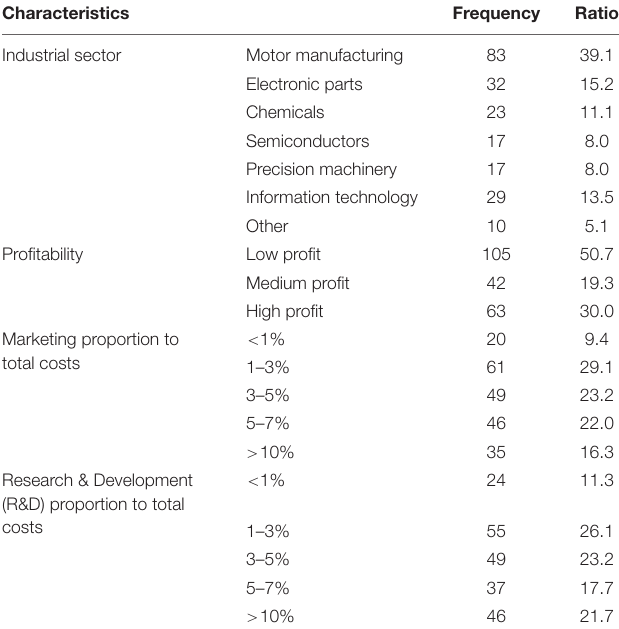
TABLE 1 | Demographic characteristics of